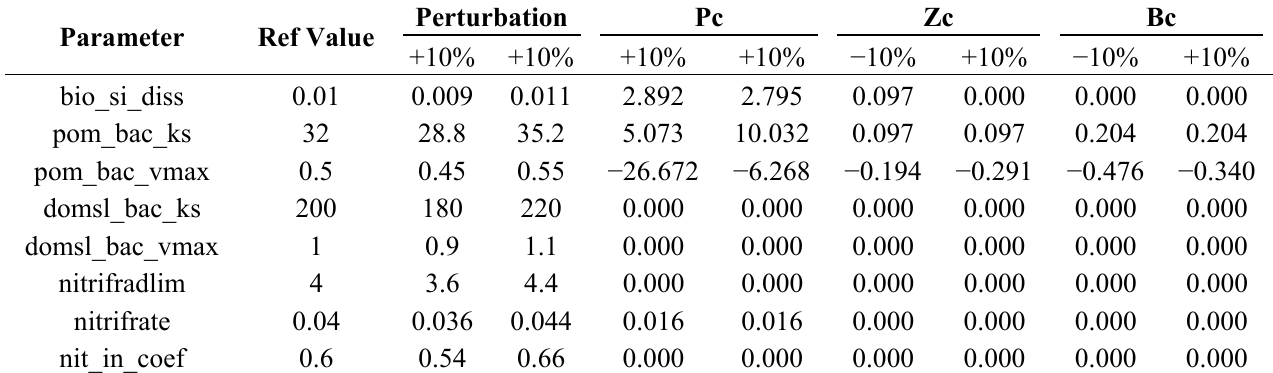
Table 7. Representation of the processing and interpretation of the SA result, Step 2: the sensitivity index is arranged in a matrix that relates input parameters and output variables.